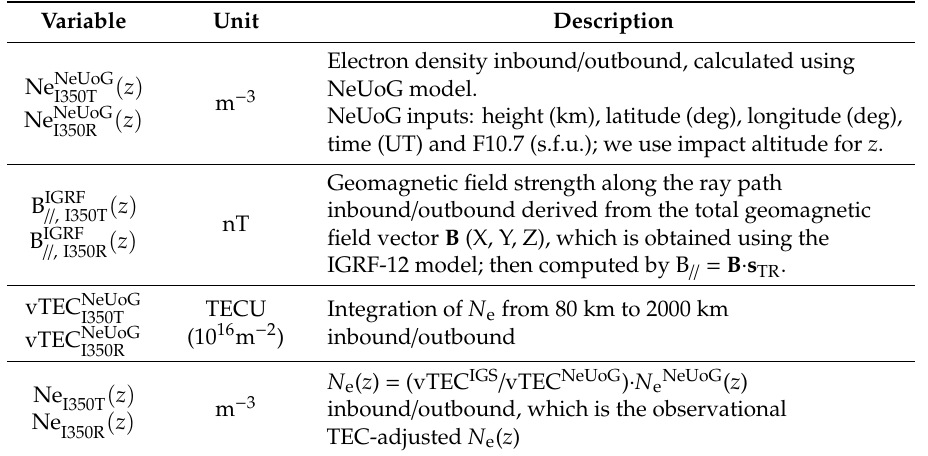
Table 2. Derived inputs for the bi-local correction, from the Electron density (Ne) University of Graz model (NeUoG) and the International Geomagnetic Reference Field (IGRF)-12 model.